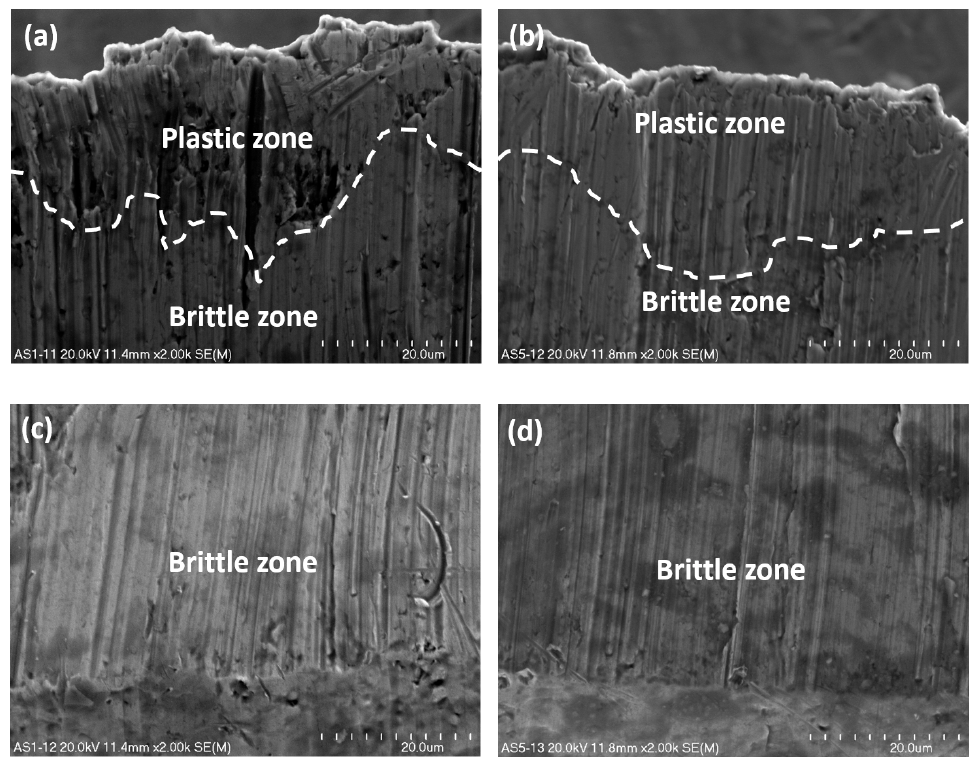
Figure 7. The upper part ( a , b ) and the lower part ( c , d ) of a surface of the top sheet in a bundle zoomed in × 2000; view from the front ( a , c ) and from the rear of a knife ( b , d ). The second sheet being cut behaves similarly to the first one in the sense that there are two characteristic zones: plastic and brittle (Figure 8). The main distinction consists in the size and number of defects in the shape of micro-voids observed in the plastic zone; they are slightly larger